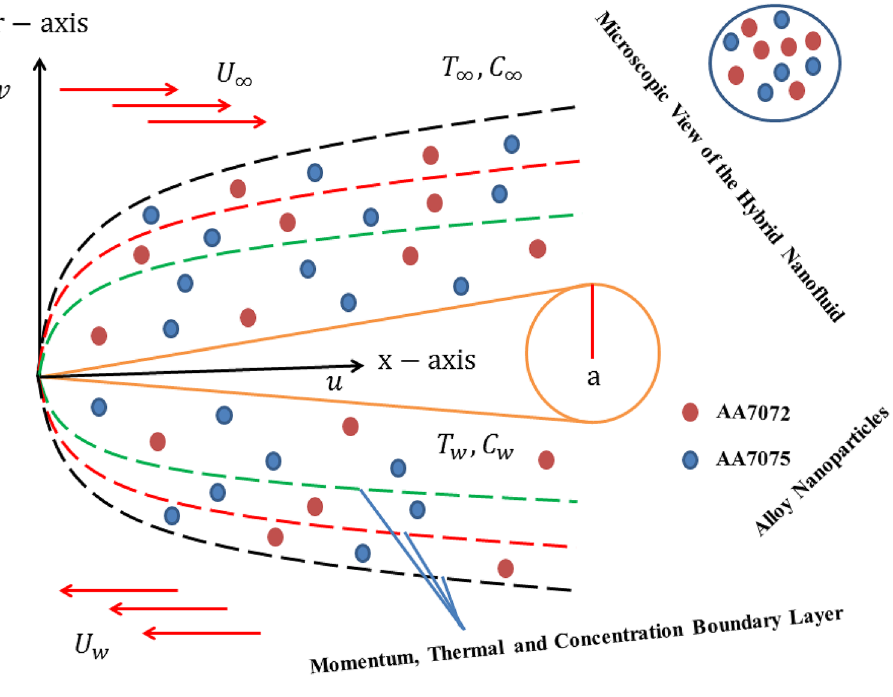
Figure 1. Physical